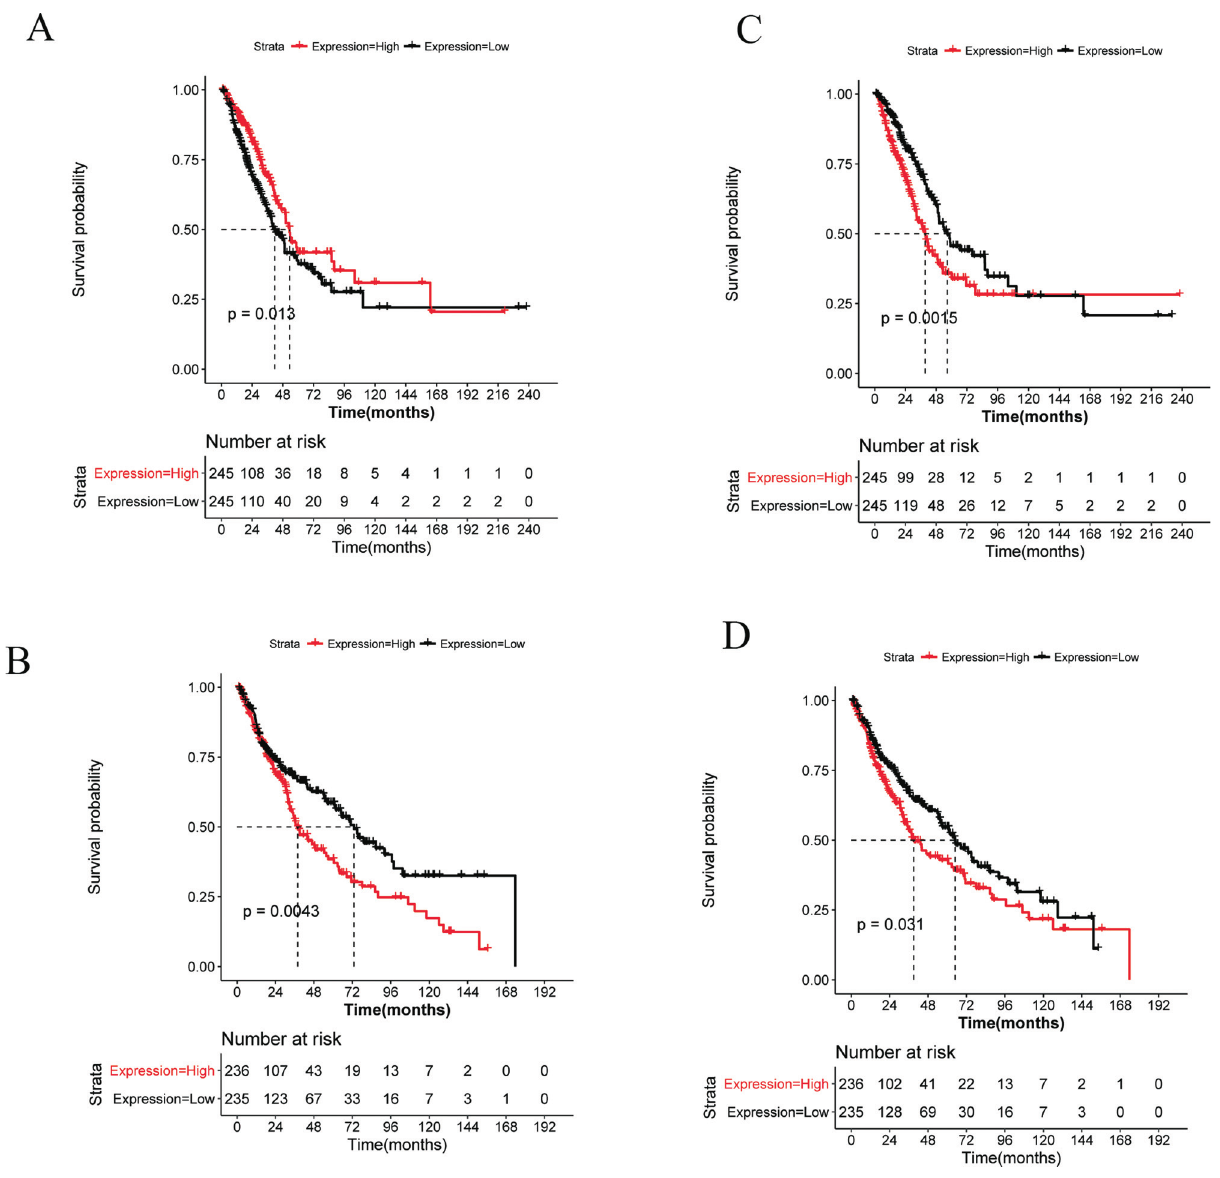
Figure 4 - The overall survival curve of key genes. (A) STXBP1 for LUAD, (B) PMEPA1 for LUAD, (C) STXBP1 for LUSC, and (D) PMEPA1 for